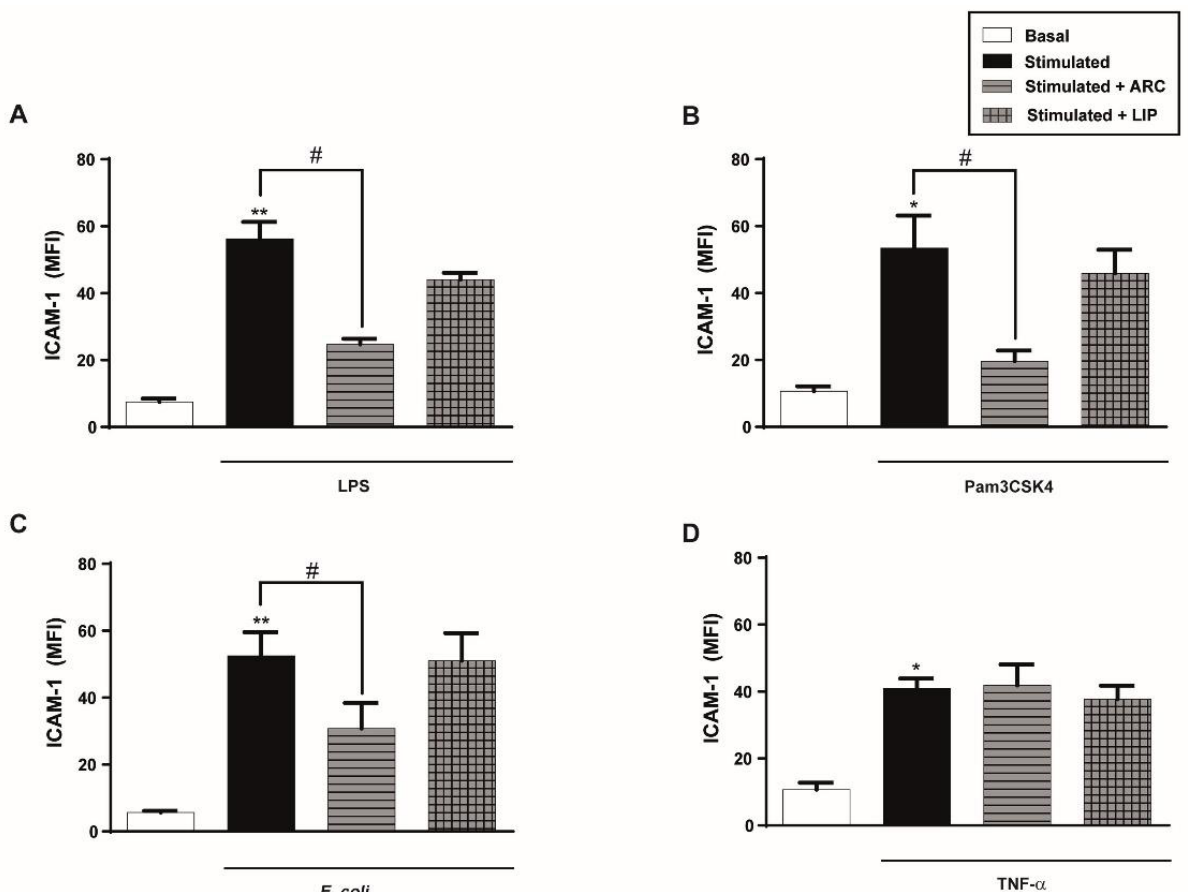
Figure 4. Preincubation with ARC also selectively inhibits ICAM-1 expression of endothelial cells. HUVEC were preincubated with nanovesicles (50 µ g/mL) for 1 h, then washed and cells were stimulated with ( A ) LPS (1 µ g/mL); ( B ) Pam3CSK4 (1 µ g/mL); ( C ) E. coli (MOI = 0.01) or ( D ) TNF- α (0.3 ng/mL). ICAM-1 expression was evaluated 18 h poststimulation. (one-way ANOVA followed by Bonferroni multiple comparisons test; * p < 0.05 and ** p < 0.01 vs. basal; # p < 0.05 between labeled groups). Results are the mean ± SEM of 4 to 5 independent experiments.